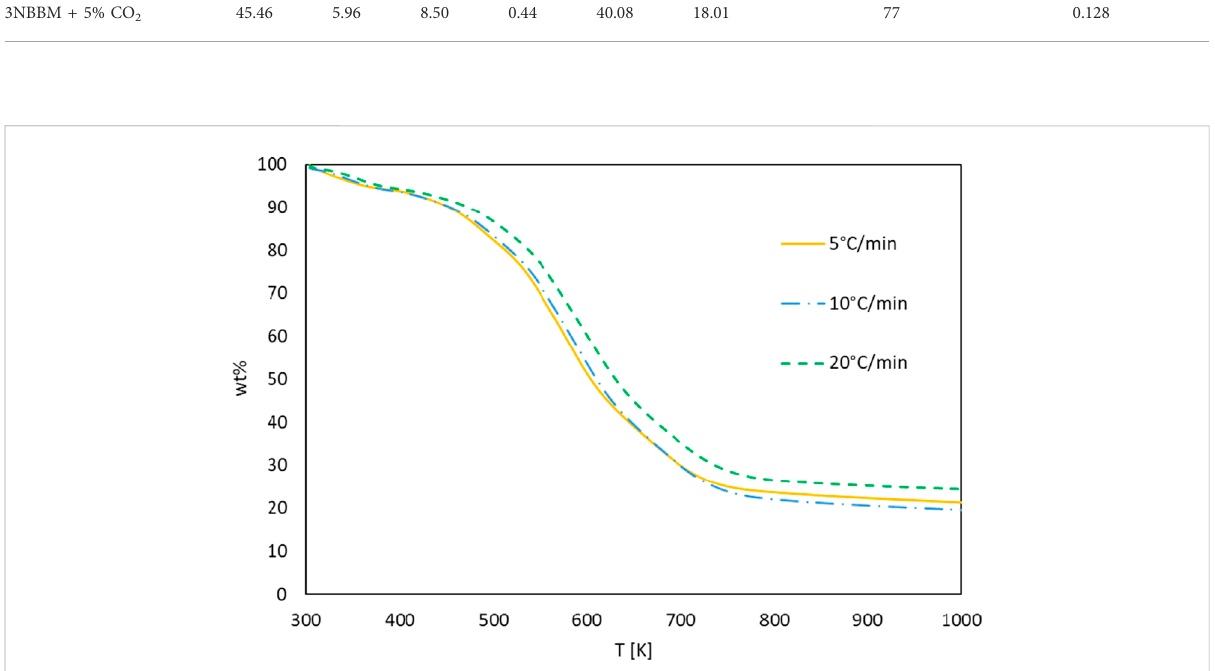
FIGURE 4 TG curves of G. pectorale at different heating